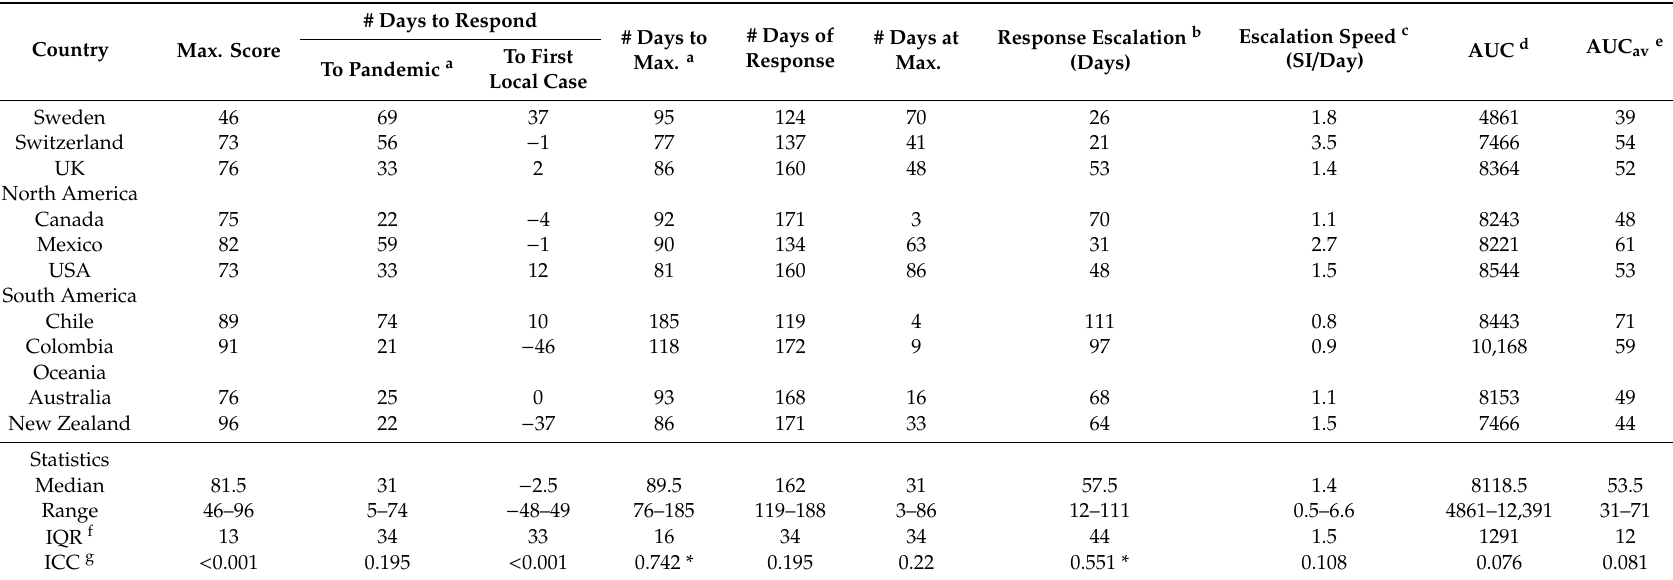
Table A2. Characteristics of Oxford Stringency Index for China and 37 OECD countries from January to July